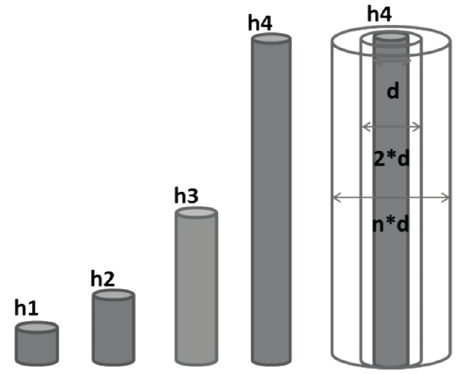
Figure 9. Schematic geometry of the waveguide cases studied.